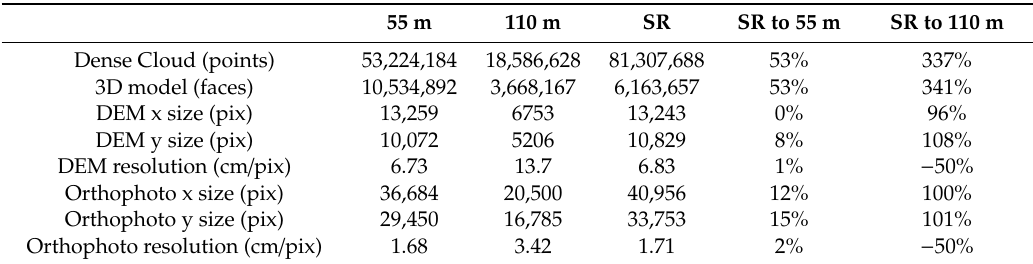
Table 9. Photogrammetric products data summary for the Mavic Pro.